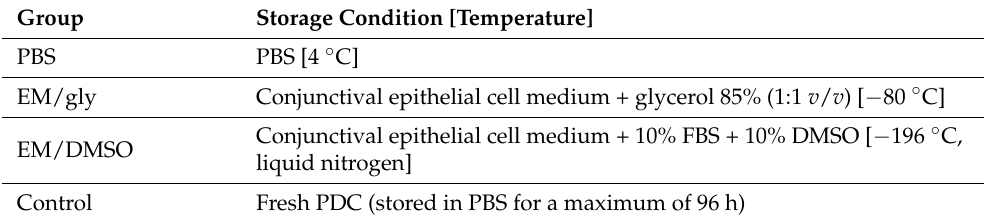
Table 2. Overview of the groups and the respective storage